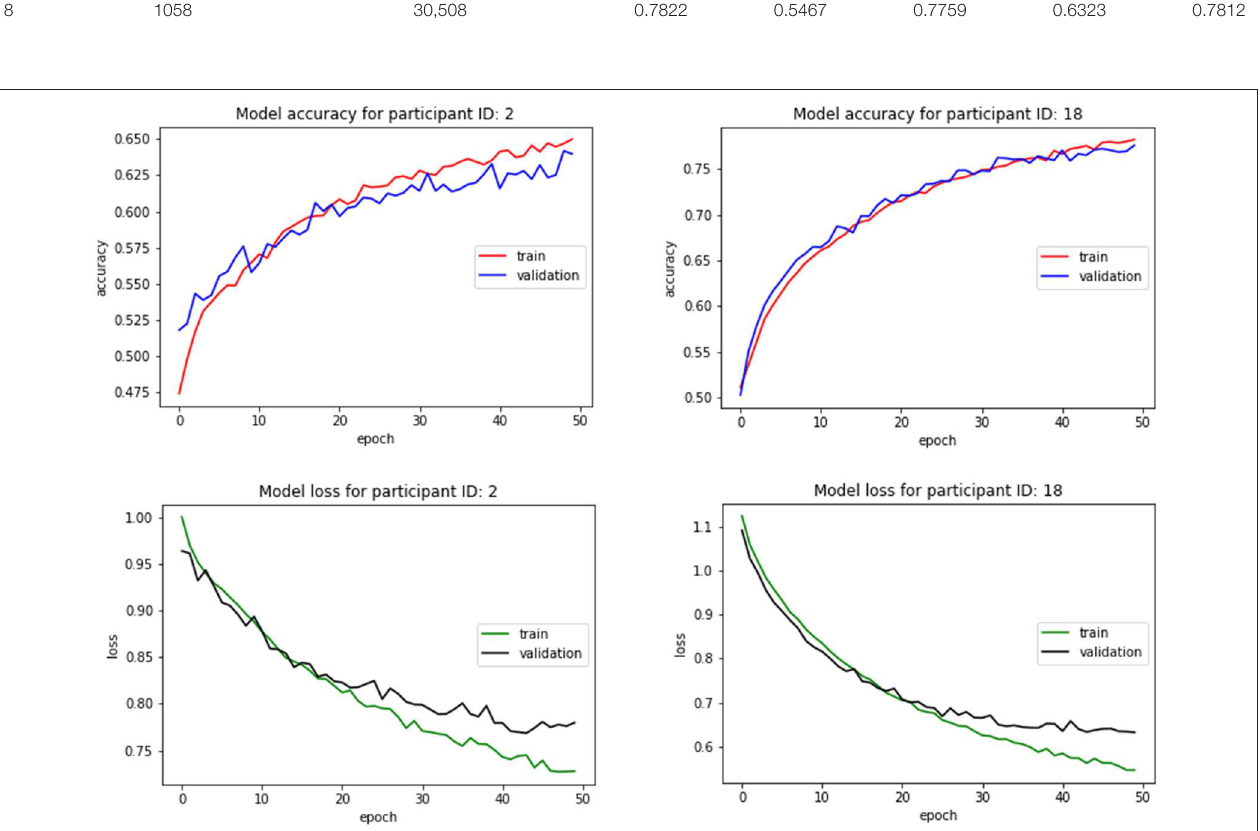
FIGURE 7 | Classifier accuracy and loss with respect to the number of epochs for two different participants.